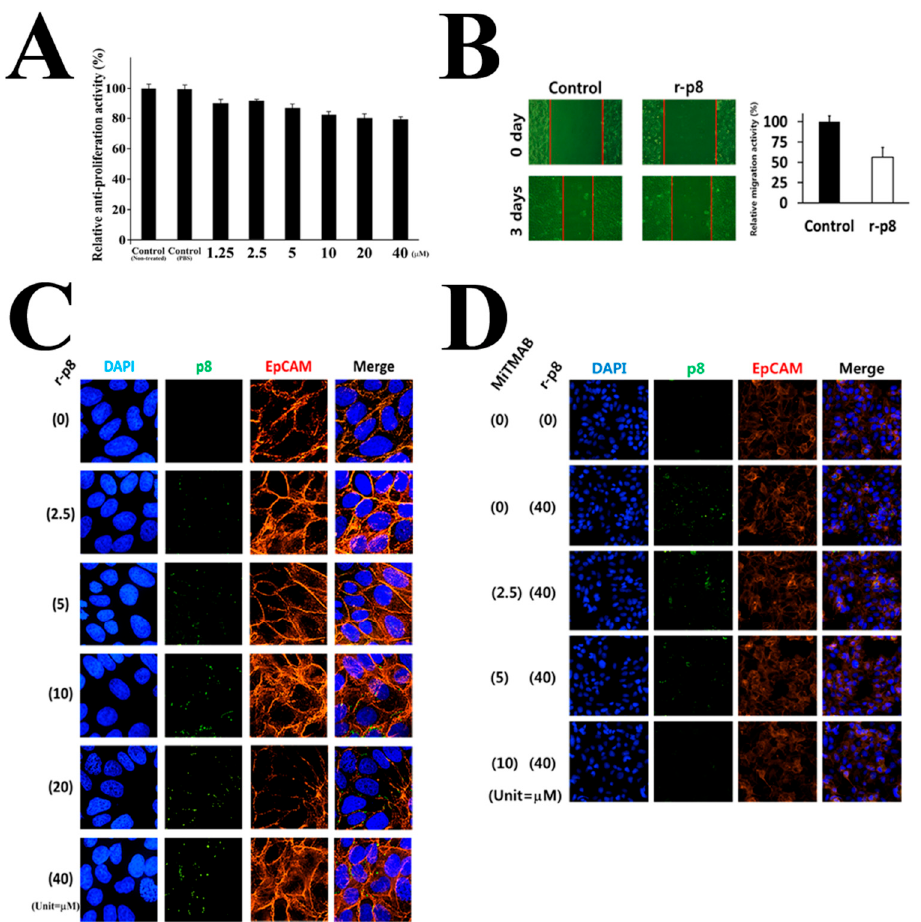
Figure 1. Characterization of p8 as an anti-cancer drug. Anti-cancer properties of exogenous r-p8 treatment. ( A ) R-p8 (0–40 µ M) was incubated with DLD-1 cells (3 × 10 3 cells / well) for 72 h, and anti-cancer e ffi cacy was determined by MTT assay. ( B ) Anti-migration properties were examined in a wound healing assay. Wound healing was analyzed using Image J. ( C ) ImageXpress ® Micro Confocal microscopy (60X) was used to determine the entry e ffi ciency of r-p8. Entry of r-p8 into cells is concentration dependent. Cells were stained to detect r-p8 (Green), the cell membrane marker EpCAM (Red), or nuclei (DAPI: Blue). ( D ) ImageXpress ® Micro Confocal microscopy (4X) was used to identify the route of entry used by r-p8. Cells were treated r-p8 (40 µ M) with or without an endocytosis inhibitor (MiTMAB: 10 µ M) and then stained to detect r-p8 (Green), the cell membrane marker EpCAM (Red), or nuclei (DAPI: Blue).